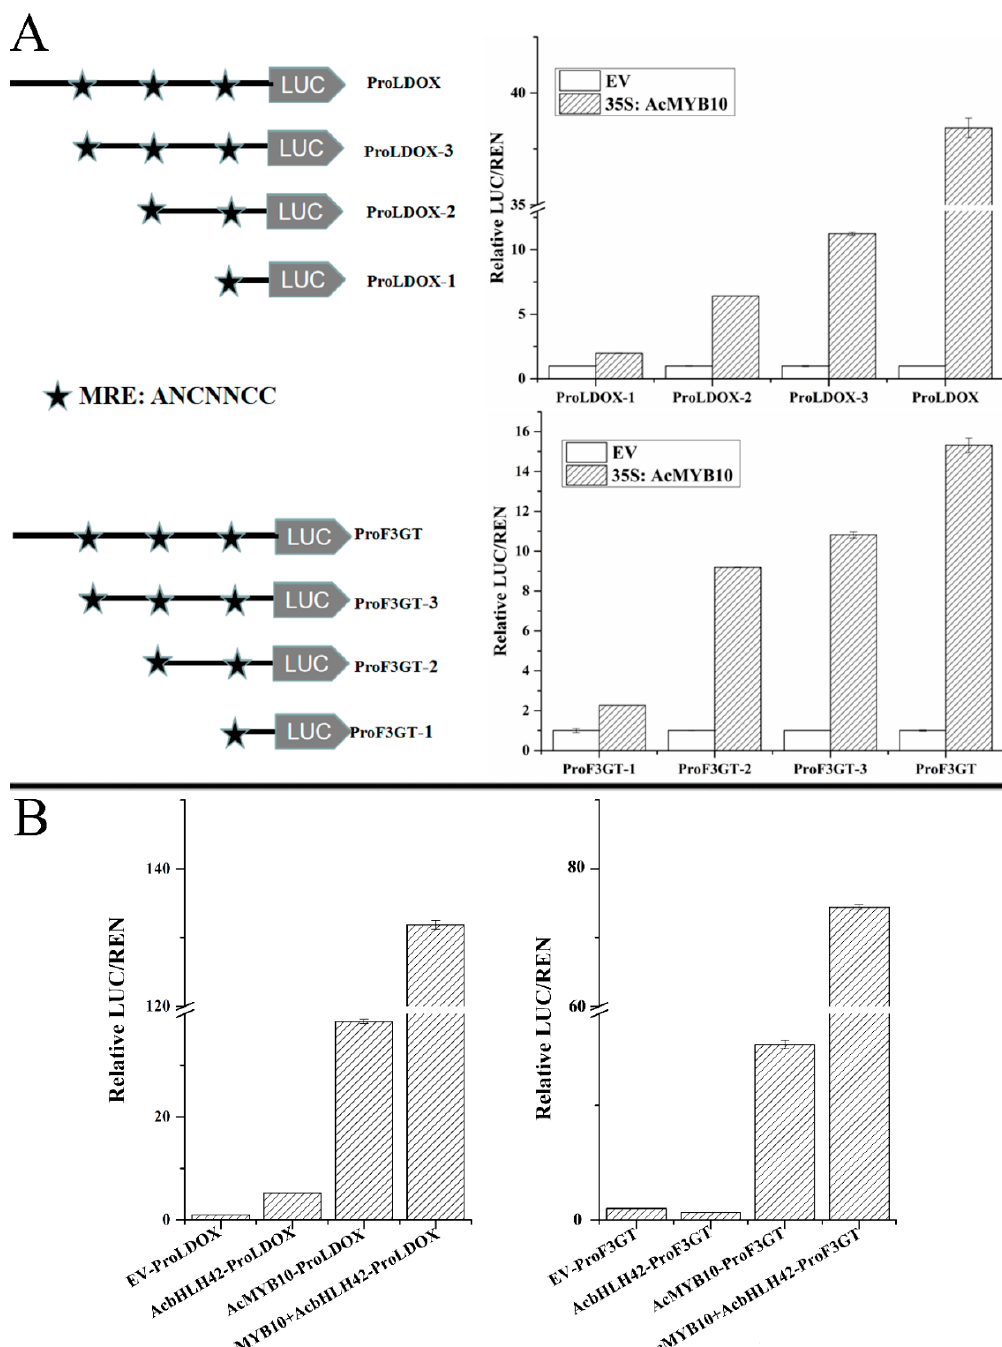
Figure 9. Transcriptional activation analysis of AcMYB10 -mediated and AcBHLH42 -mediated induction of AcLDOX and AcF3GT promoter activities. ( A ) Diagrams showing various DNA fragments of the two selected promoters linked to the firefly luciferase reporter. ( B ) AcMYB10 -mediated and AcBHLH42 -mediated induction of AcLDOX and AcF3GT promoter activities. LUC, Firefly luciferase activity; REN, Renilla luciferase activity. The ratio of LUC / REN of the empty vector (EV) plus promoter was used as a calibrator (set as 1). Results represent the mean ± SD of six replicates. 2.11. AcMYB10 Interacts with AcbHLH42 to Activate Anthocyanin Biosynthesis in N. tabacum Leafs and